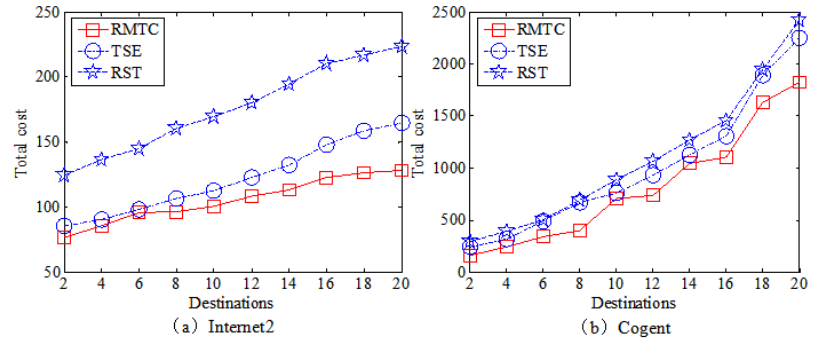
Figure 11. Impact of the number of destinations in ( a ) Internet2, ( b ) Cogent.